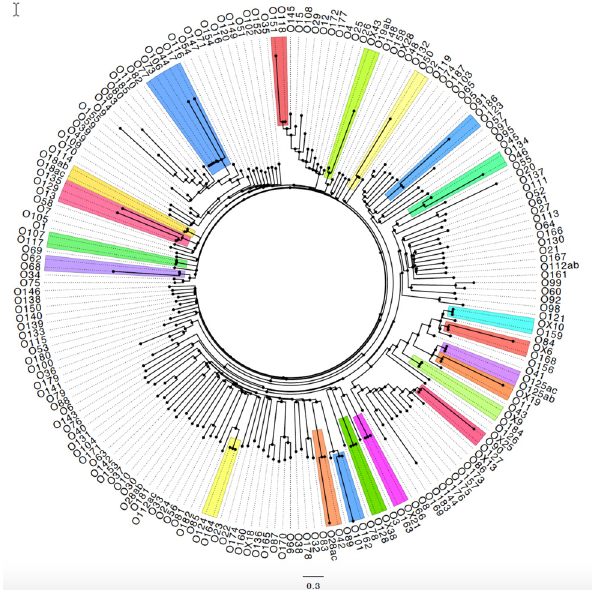
Fig 1. Phylogenetic tree for all O-AGCs of E . coli . The O-AGCs that show 98 – 99.9% relatedness are